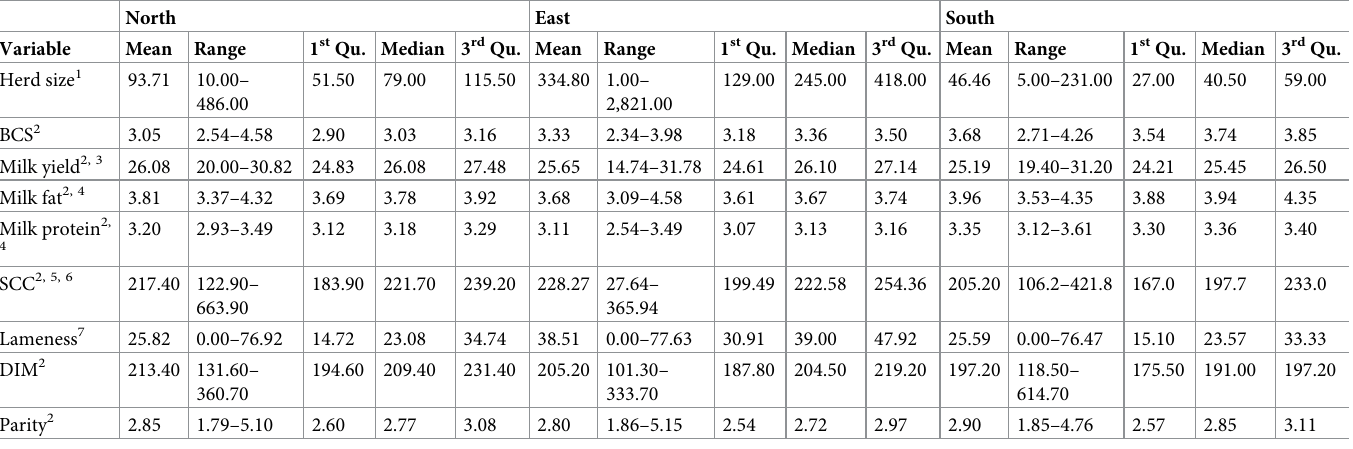
Table 1. Descriptive statistics of the data across the three study regions (North = 191 farms, East = 201 farms, South = 214 farms). North East South Variable Mean